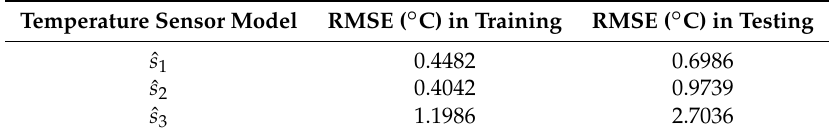
Figure 13. Temperature estimation associated to each physical sensor node s 1 , s 2 and s 3 in comparison with the actual values. Left side of the vertical line refers to training data and right side refers to the testing data. Table 2. Output response of the temperature estimations in training and testing, using AHN-models.